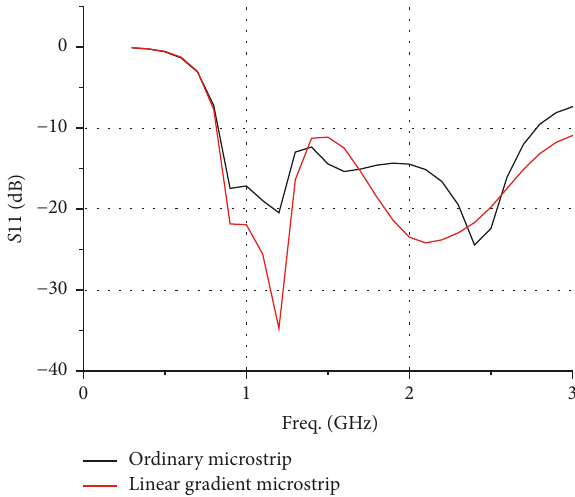
Figure 4: Influence of different microstrips on the return loss of the